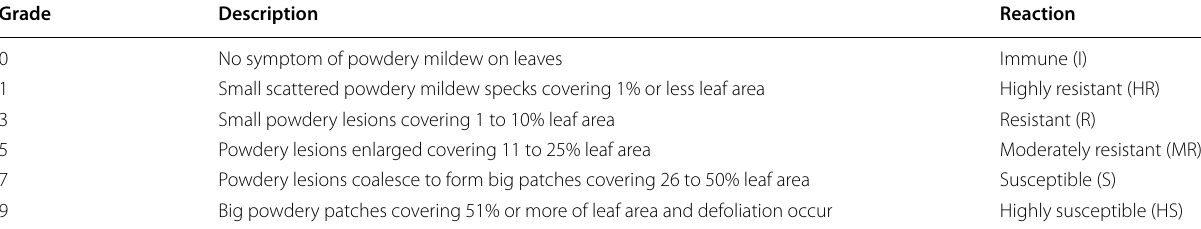
Table 1 Key of disease severity of sunflower powdery mildew